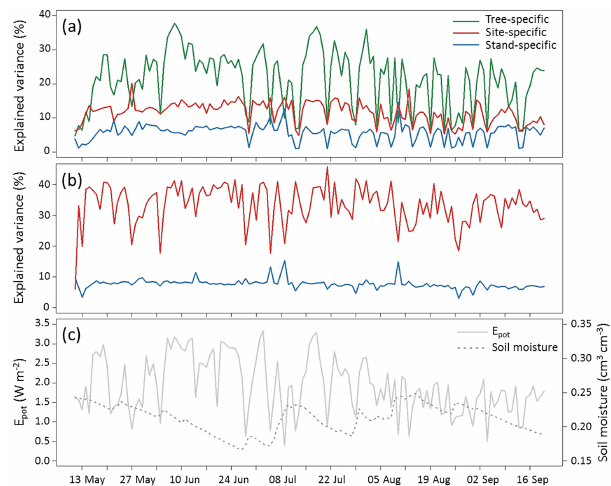
Figure 9. Explained variance of the daily linear models, separated according to the predictor groups used in the regression, (a) for sap velocity and (b) for sap flow. (c) Catchment average of soil moisture and potential evaporation E pot